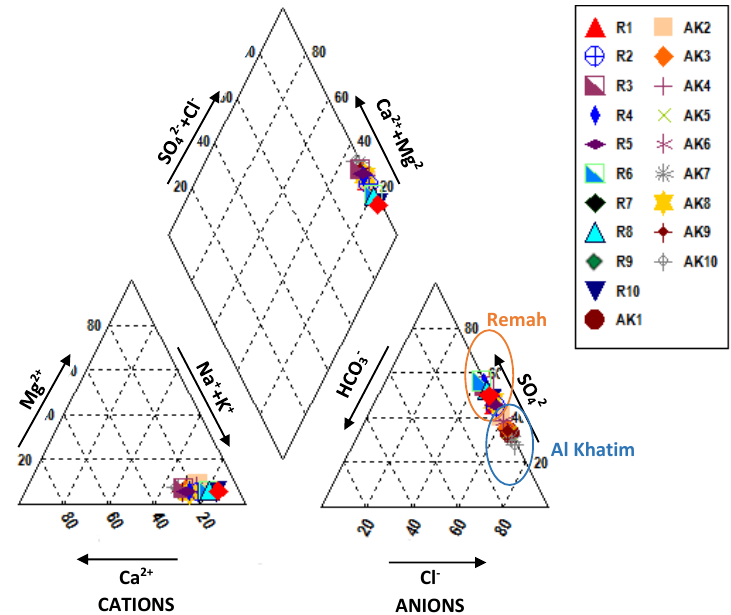
Figure 12. Piper plot for Remah (R) and Al Khatim (AK).